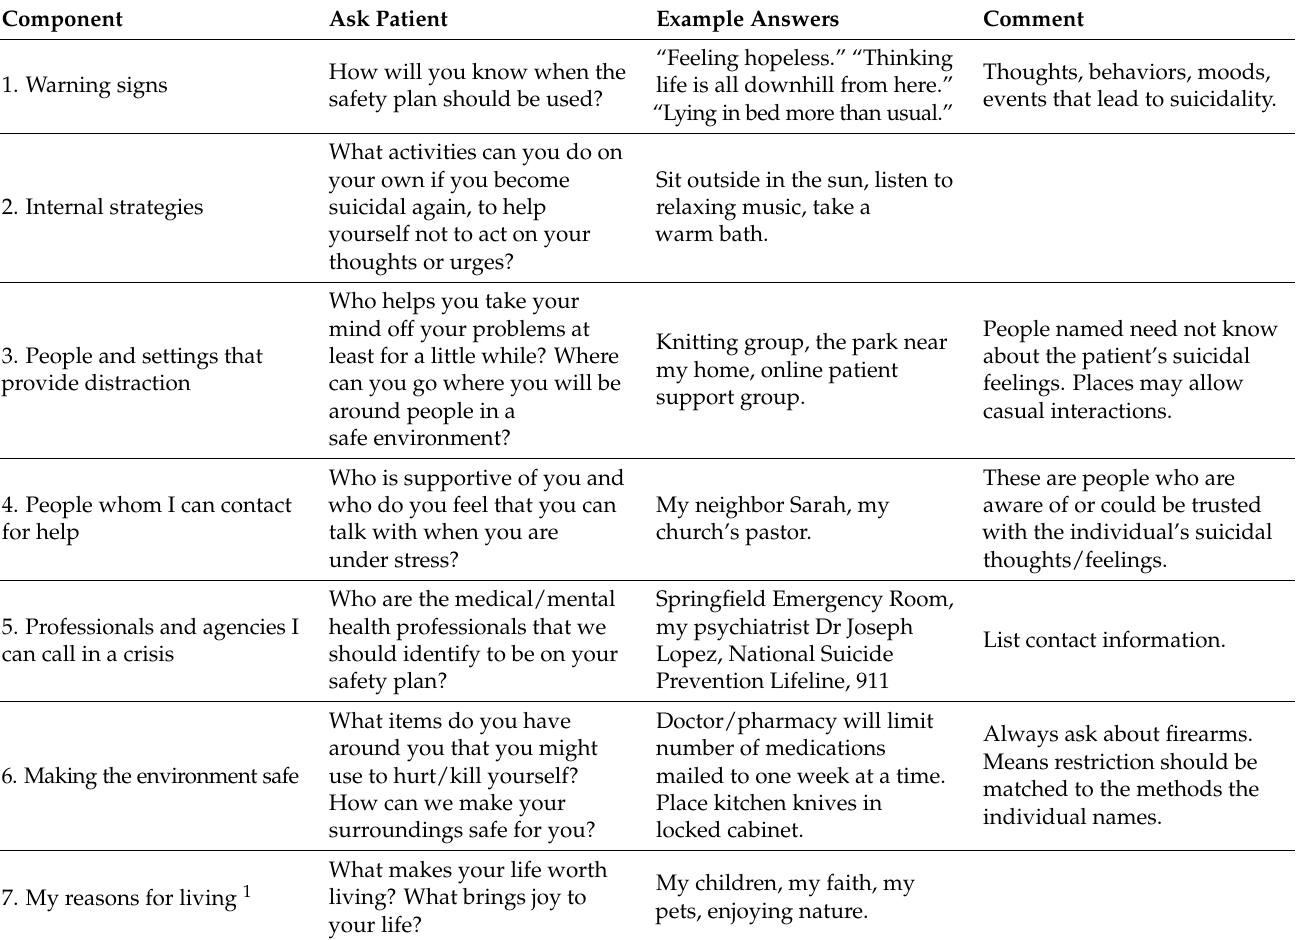
Table 4. Suicide safety plan by Brown and